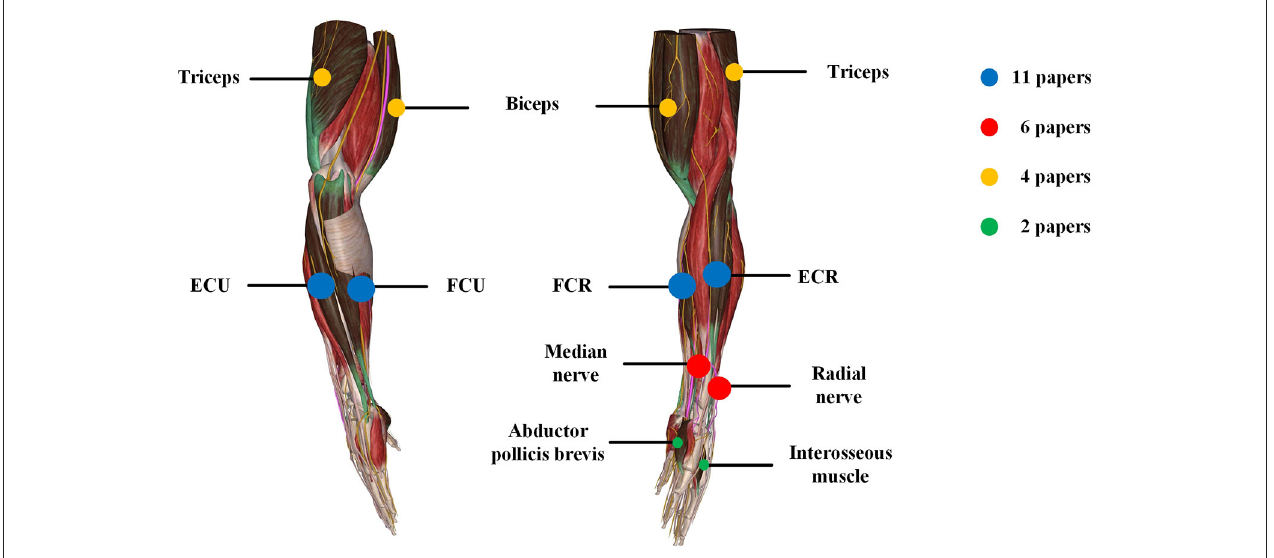
FIGURE 3 | Summary of locations of electrical stimulation from the reviewed articles. The color represents different stimulation location and circle size represents the number of papers.